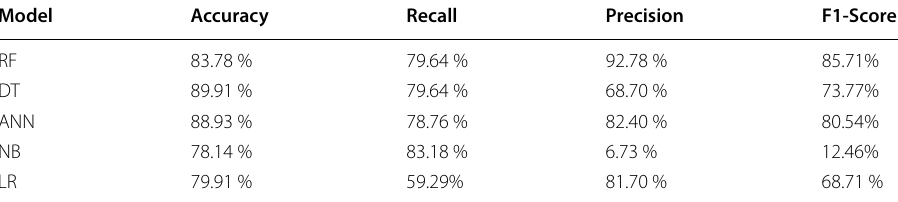
Table 8 Classification results a random approach